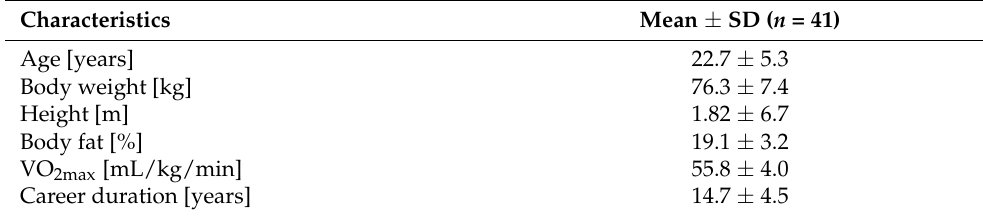
Table 1. Participants’ characteristics.